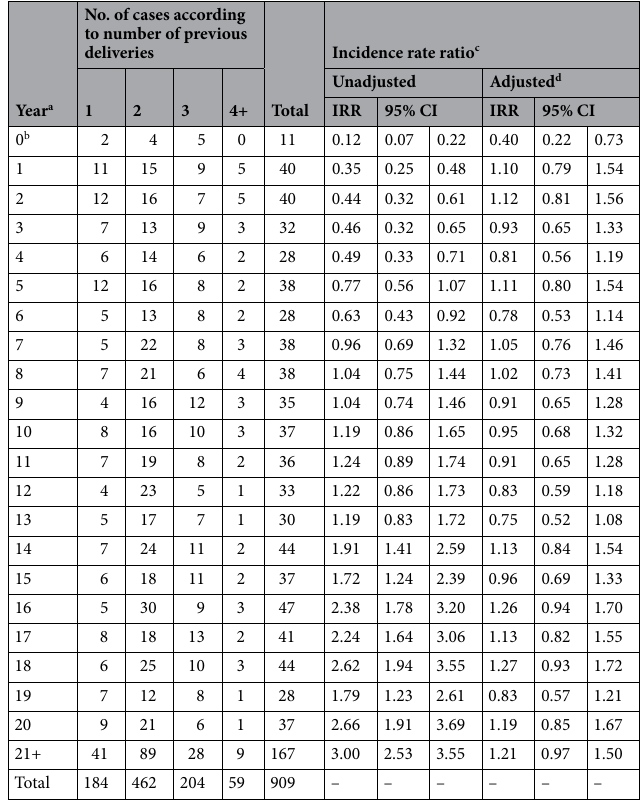
Table 3. Number of meningioma tumors diagnosed during pregnancy and number of years since last delivery by delivery number. Unadjusted and adjusted incidence rate ratio (IRR) with 95% confidence intervals by number of years since last delivery. Women with at least one delivery during the follow-up period 1973–2015. –, Not applicable. a Number of years since last delivery. b Time during pregnancy. c Incidence rate ratio for number of years since last delivery versus all other years. d Adjusted for attained